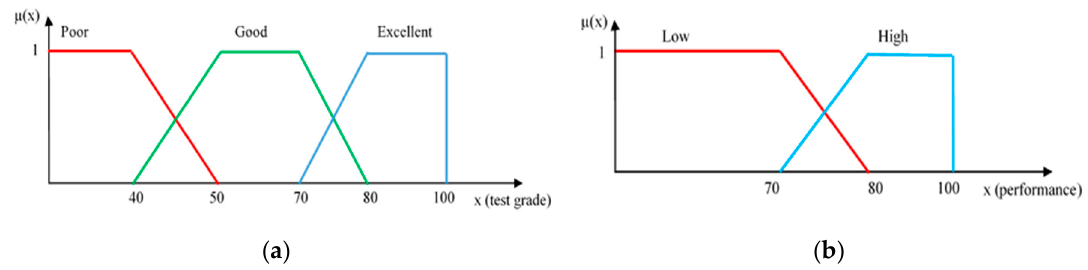
Figure 3. ( a ) The membership functions of the test grade, ( b ) The membership functions of the output.